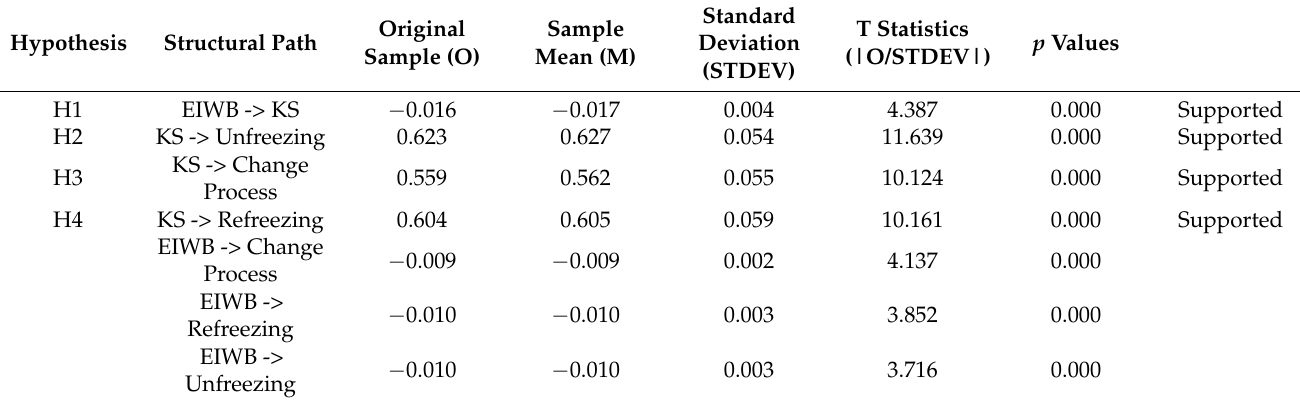
Table 5. Hypotheses testing results.